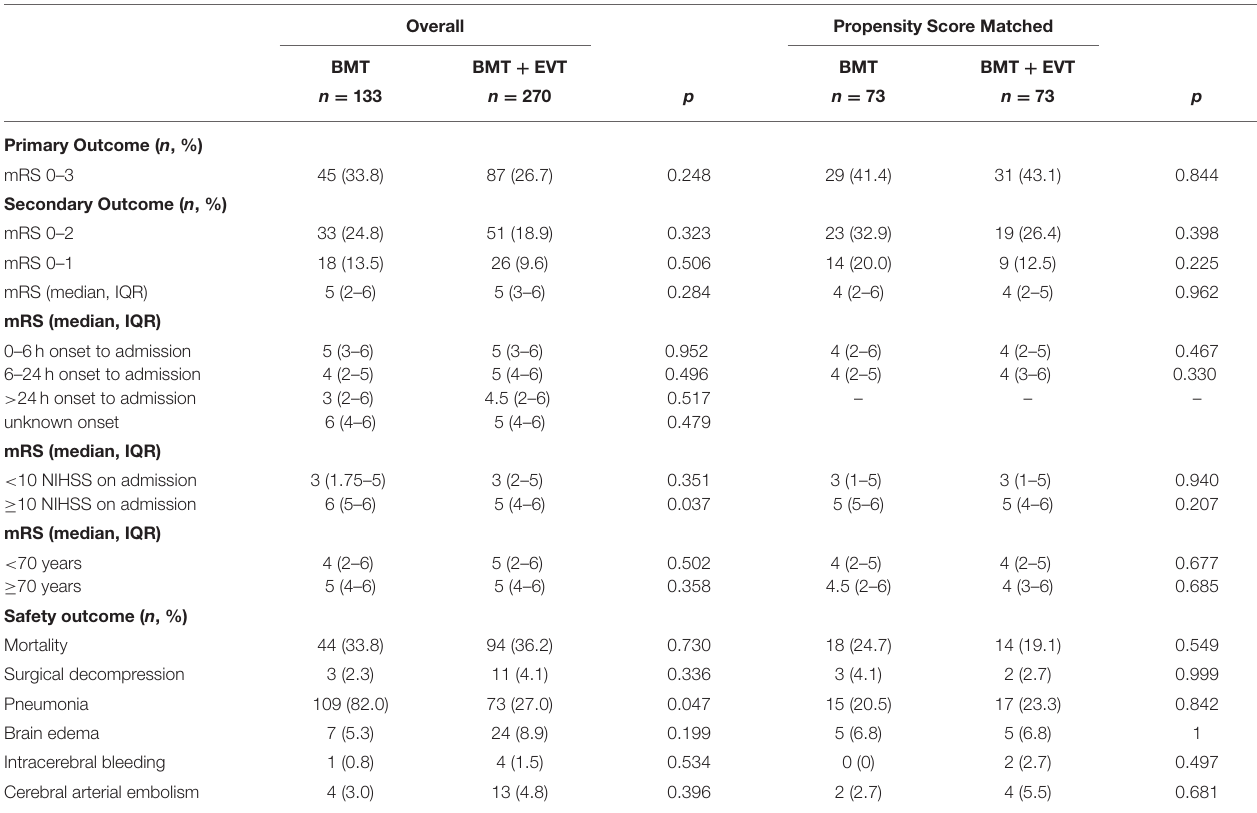
TABLE 2 | Primary and secondary efficacy outcomes and safety outcomes. Overall Propensity Score